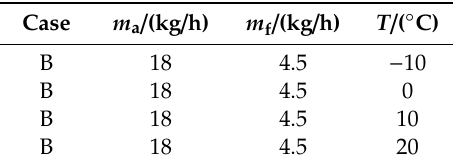
Figure 11. Liquid film breakup processes of different fuel temperatures (Case B) (Transient results). Table 4. Experiment conditions.